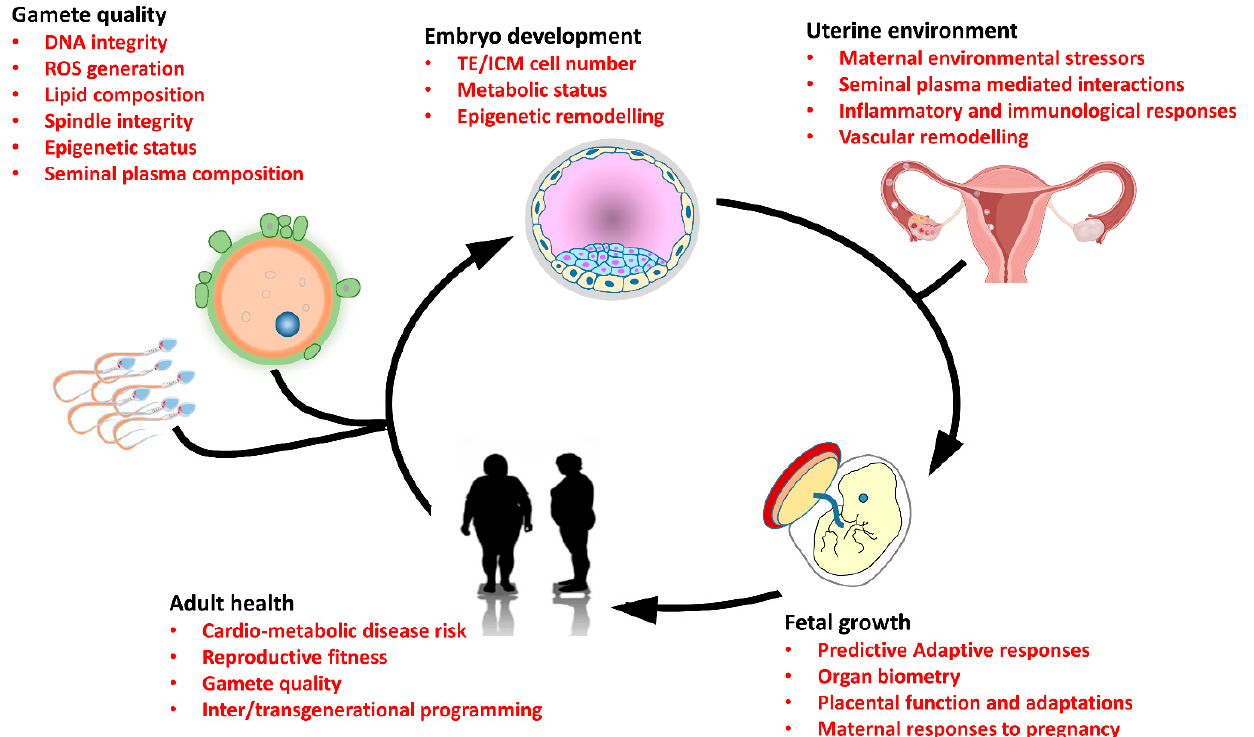
Figure 1. Diagram depicting the central factors linking parental environmental and lifestyle aspects with gamete quality, preimplantation embryo development, fetal growth and adult offspring health. Exposure of parents to poor-quality diet, environmental toxins and pollutants or advancing age can all negatively impact gamete quality, impairing DNA integrity and elevating levels of damaging reactive oxygen species (ROS). Poor-quality gametes at the time of conception subsequently perturb preimplantation embryo development, altering the genome-wide epigenetic remodeling that takes place and affecting cell numbers within the initial embryo lineages, the inner cell mass (ICM) and trophectoderm (TE). Within the uterine environment, factors such as maternal diet, pollution, advancing age and/or stress can directly impact the developmental dynamics and long-term trajectory of the preimplantation embryo through alterations in immune cell populations. In addition, paternal seminal plasma components have also been shown to influence the uterine environment, modulating the proportions of immune cells, as well as inflammatory responses and vascular remodeling, all essential for successful embryo implantation. In late gestation, differential fetal growth can occur through perturbed nutrient provision and dysfunctional placental transport. Here, disproportional fetal growth dynamics result in significant changes in tissue structure and function. These fetal predictive adaptive responses can then predispose the adult offspring to an increased risk of developing a range of non-communicable cardio-metabolic diseases in adult life, which can impact on the quality of their own gametes and the health of subsequent generations.